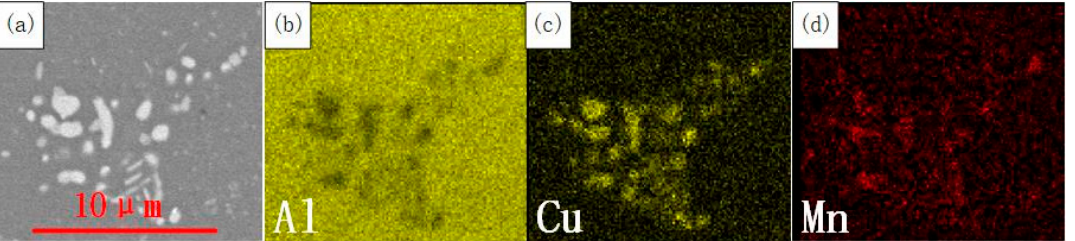
Figure 4. SEM results of ACMZ alloy with different content of nanoparticles after as-cast and iso- thermal holding + solid solution (IS) treatment. ( a ) ACMZ, as-cast; ( b ) ACMZ-0.1 nanoparticles, as- cast; ( c ) ACMZ-0.3 nanoparticles, as cast; ( d ) T phases in ACMZ, isothermal holding; ( e ) ACMZ, IS; ( f ) ACMZ-0.1 nanoparticles, IS; ( g ) ACMZ-0.3 nanoparticles, IS; ( h ) T phases in ACMZ-0.3 nanopar- ticles, isothermal holding. Figure 5. The EDS map of the residual part after solid solution, ACMZ. ( a ) SEM area of residual structure after solid solution; ( b ) Al in this area; ( c ) Cu in this area; ( d ) Mn in this area.